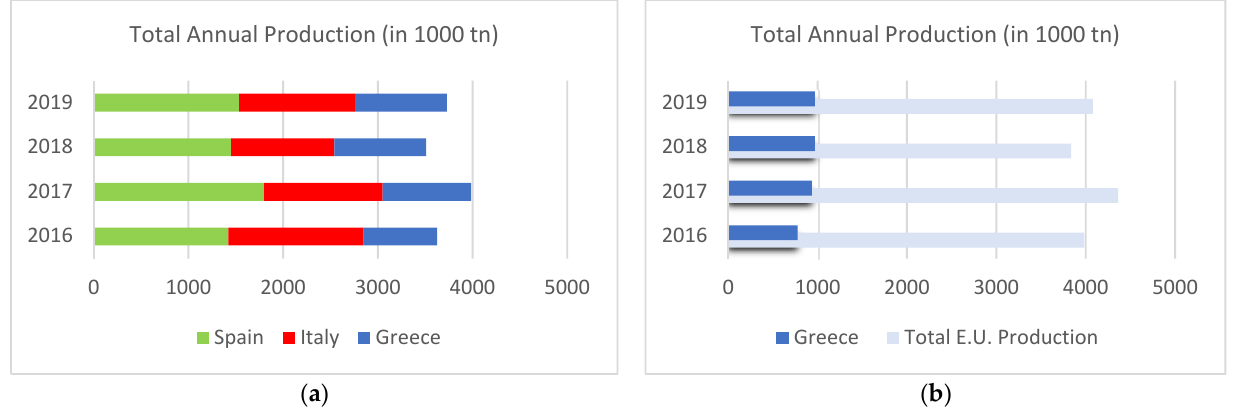
Figure 1. Average annual production of peaches and nectarines for the years 2016–2019: ( a ) for the three most important producing countries of the European Union, ( b ) for Greece in relation to the total production of the member states of the European Union (source: Eurostat).